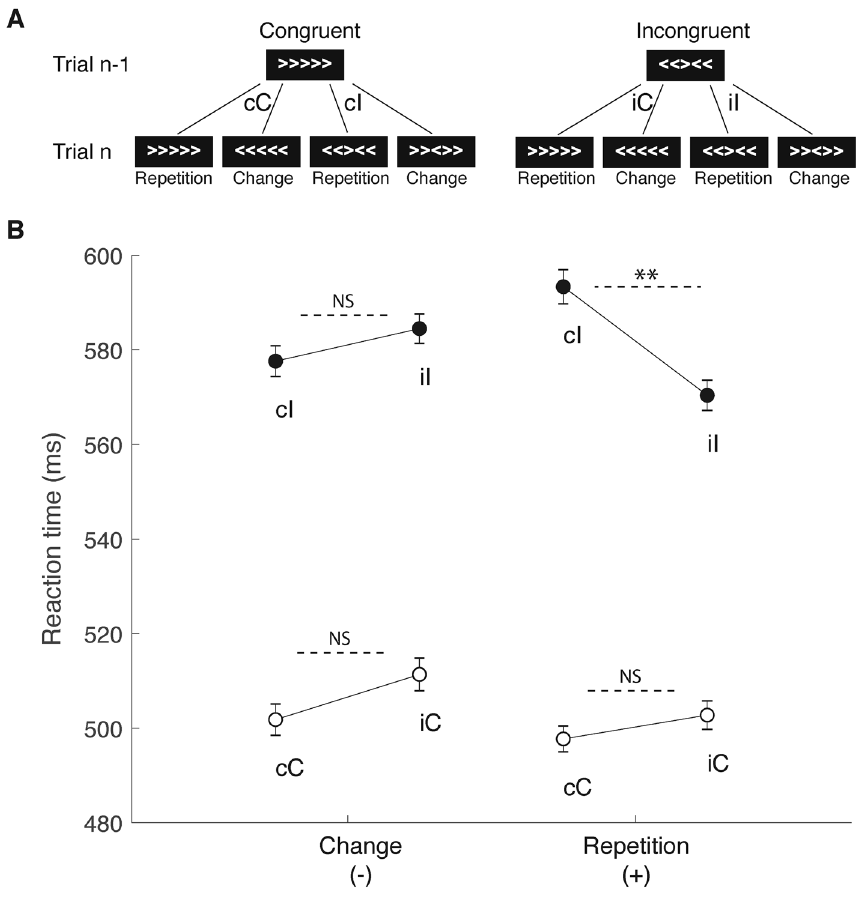
Figure 2. ( A ) examples of trial-to-trial transition in the flanker task. ( B ) Behavioral measurements for all (flexion or extension) movements. Values are mean (± SE) reaction times (RTs) during trial n as a function of congruency of the stimulus in trial n (C or I) and trial n−1 (c or i). The data are grouped according a change (−) or repetition (+) of stimulus direction between trial pairs. A significant conflict-adaptation effect (iI < cI) was found only in the case of stimulus repetition but not stimulus change. **p < 0.01 (see also Table